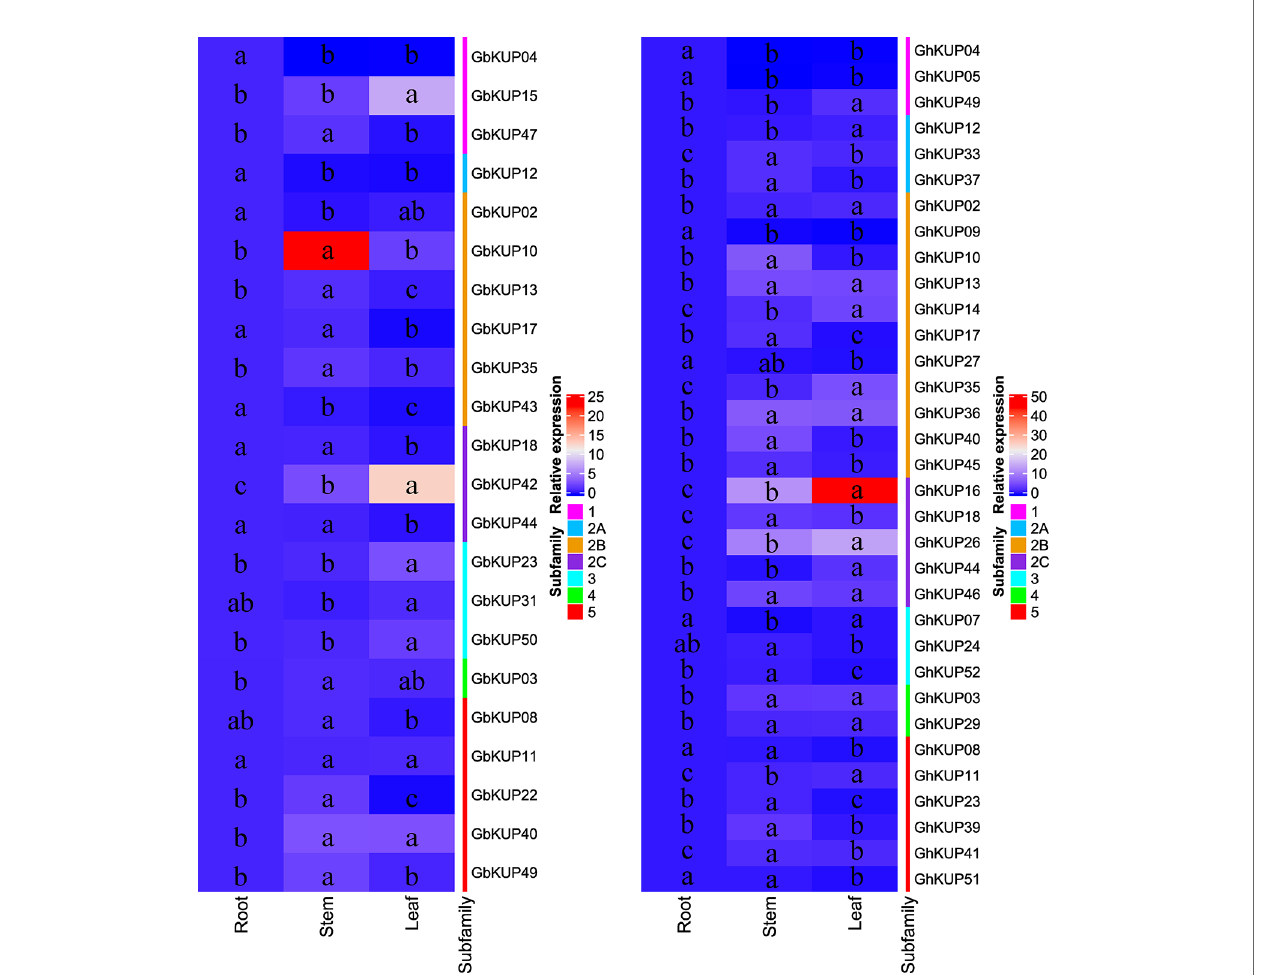
FIGURE 5 | Heat map representation of GhKUP and GbKUP expression levels in roots, stems, and leaves. Two color bars represent relative expression values and KUP subfamilies. Expression levels with the same letter in each cell do not signi fi cantly differ at P < 0.05 as revealed by Duncan ’ s multiple